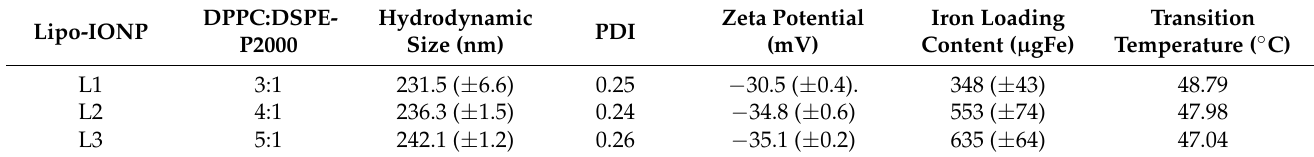
Figure 2. Physical characterization of Lipo-IONP. ( A ) Transmission electron microscopic (TEM) images of Lipo-IONP. ( B ) Hydrodynamic size distribution of Lipo-IONP. ( C ) Size stability of Lipo-IONP. ( D ) Superparamagnetic properties of Lipo-IONP measured by superconducting quantum interference device (SQUID) (Lipo-IONP: liposomal iron oxide nanoparticle). Table 1. Physical characterization of Lipo-IONP synthesized with different lipid ratios.